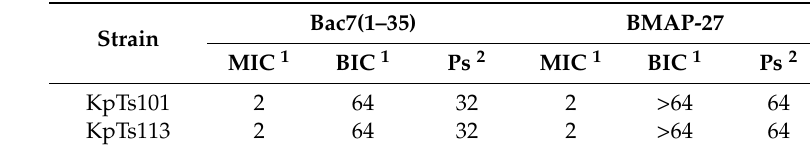
Table 2. Antimicrobial activity of Bac7(1–35) and BMAP-27 towards KpTs101 and KpTs113 K. pneumoniae isolates. Activities are given as MIC for planktonic cells, as BIC for biofilms, and as MIC in the presence of matrix polysaccharides (Ps).